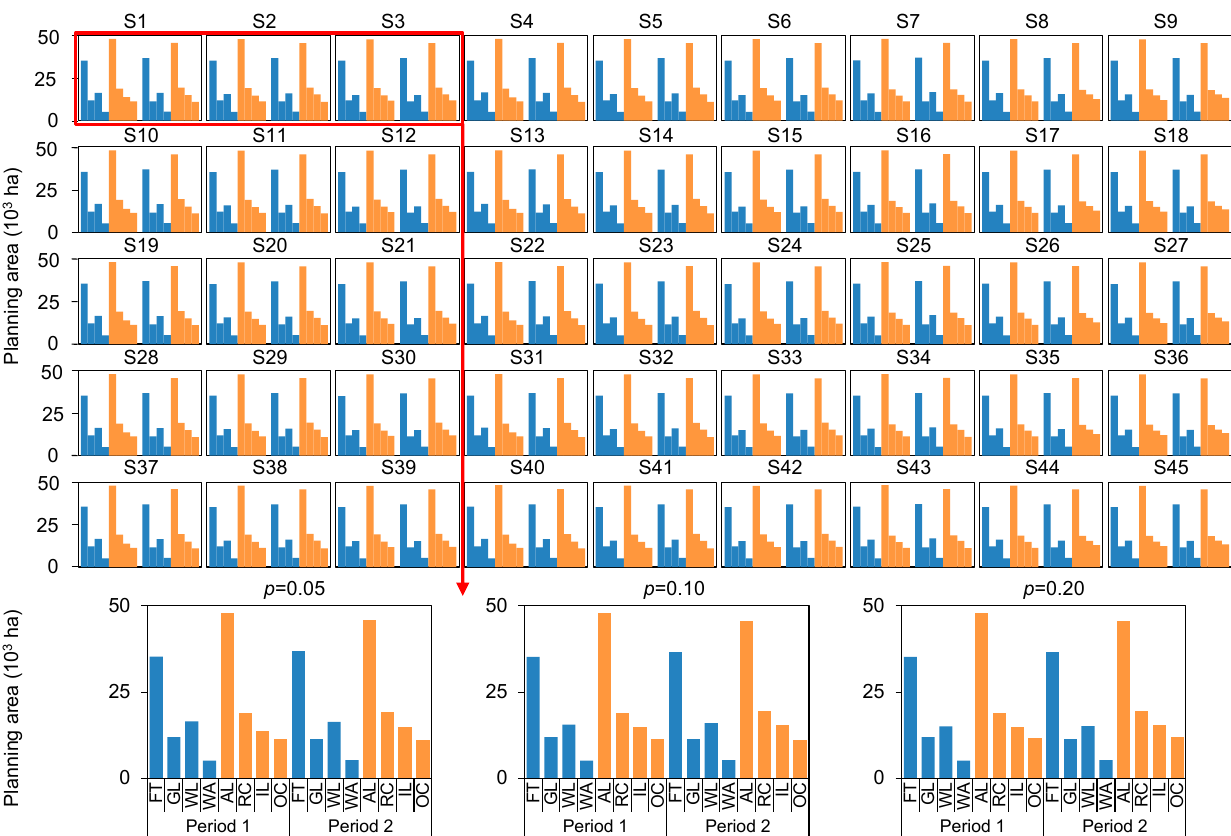
Figure 4. Planning area under different scenarios [symbols “FT, GL, WL, WA, AL, RC, IL, and OC” denote “forest, bushland, wetlands, water area, agricultural land, commercial and residential land, industrial land, and public land”, respectively].